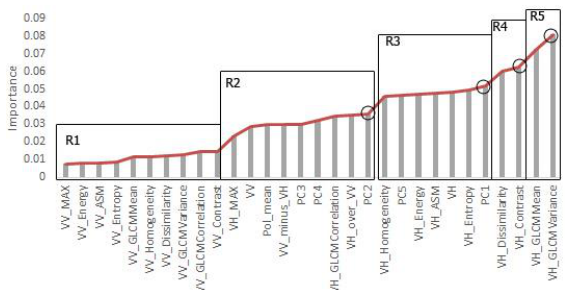
Figure 10. Variable importance plot. Boxes represent